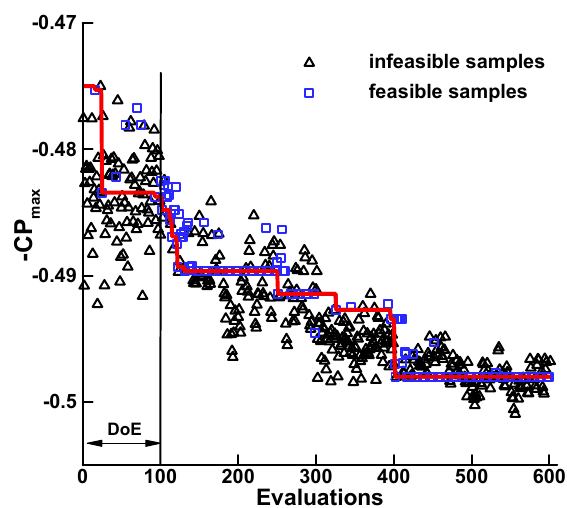
Figure 18. Convergence history of optimization design.